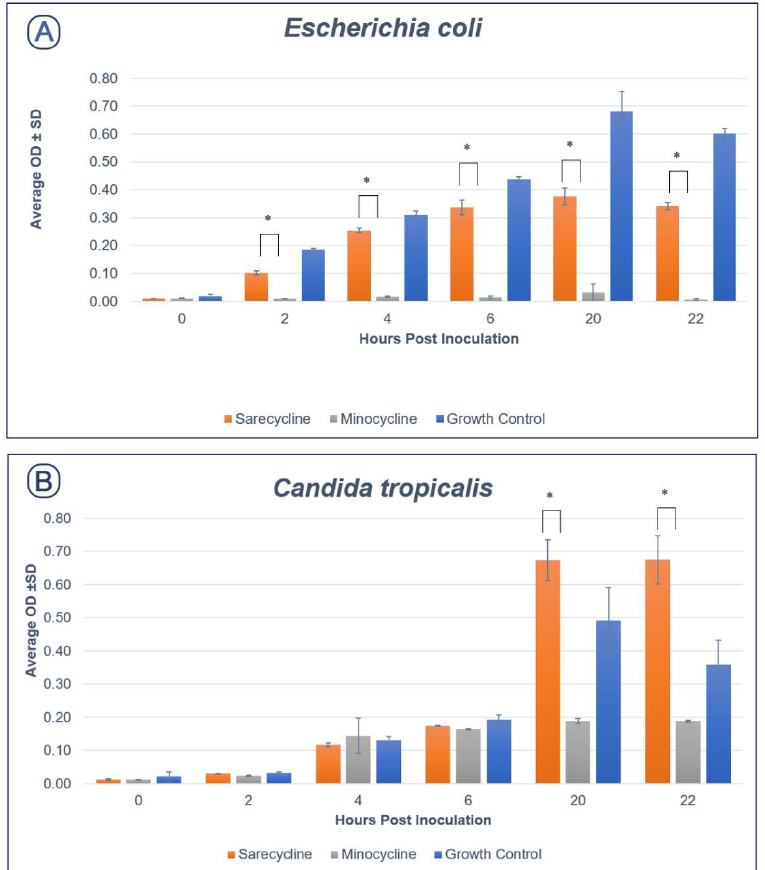
Figure 1. Histograms for Escherichia coli ( A ) and Candida tropicalis ( B ) in the presence of sarecycline and minocycline as measure by optical density (OD). * Sarecycline showed significantly less antimicrobial activity when compared to minocycline, p -value of